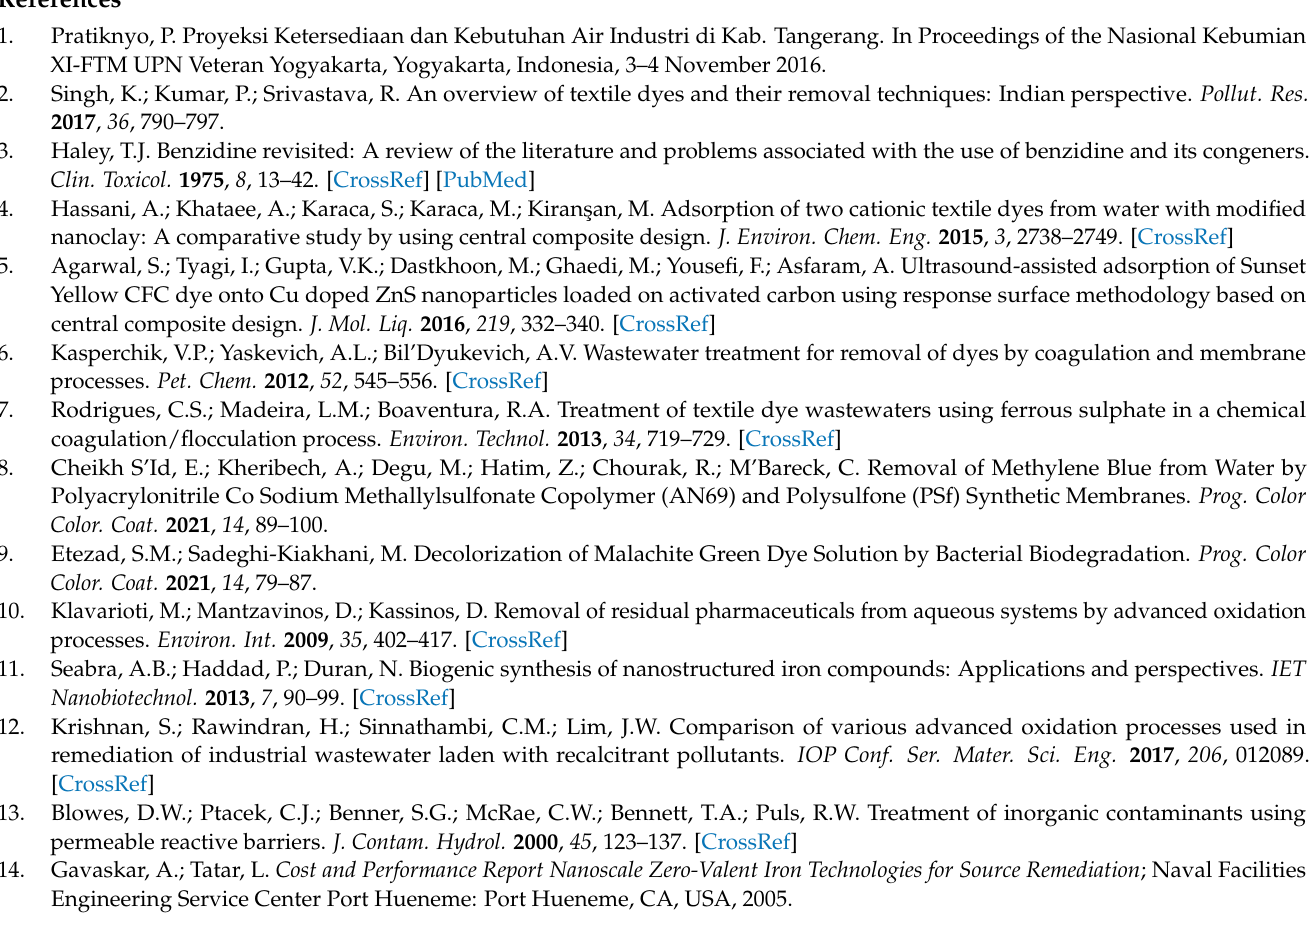
tion; Figure S2: (a) The curve of absorption wavelength of gallic acid; and (b) The curve of optimum incubation time for gallic acid at 698 nm; Figure S3: The curve of the gallic acid calibration standard; Figure S4: (a) Color of 0.1 M iron(II) sulfate solution; (b) Tea extract heated at 90 ◦ C for 80 min; (c) syn- thesized nZVI before evaporation; (d) nZVI solid 1:1, (e) 1:2, and (f) 1:3; Figure S5: Absorbance of ZVI catalytic test for 50 mg/L ZVI concentration; Figure S6: Absorbance of ZVI catalytic test for 100 mg/L ZVI concentration; Figure S7: Absorbance of ZVI catalytic test for 150 mg/L ZVI concentration; Figure S8: Absorbance of iron(II) sulfate catalytic test for 150 mg/L iron(II)